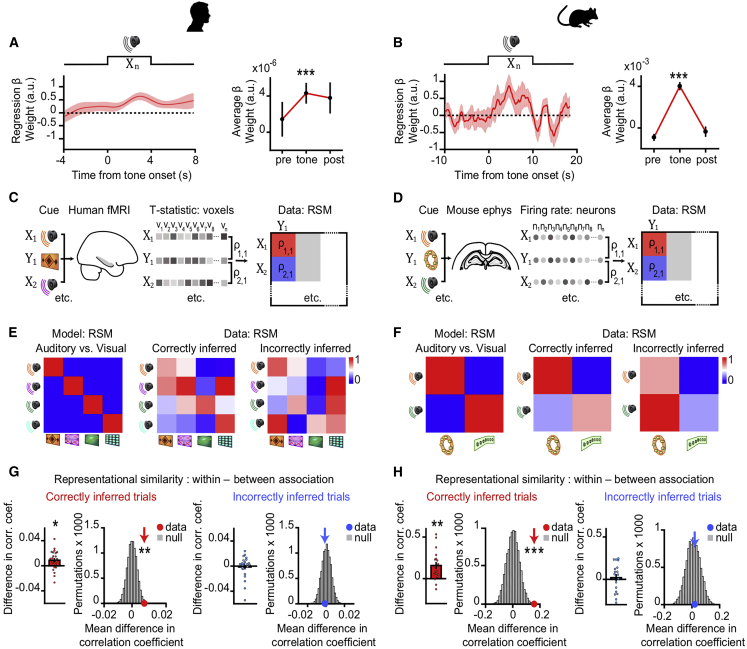
Hippocampal Prospective Memory Code during Correct Inference in Humans and Mice(A and B) During auditory cues Xn in the inference test, the BOLD signal (humans; A) and the Z scored firing rate of each dCA1 neuron (mice; B) were regressed onto the behavioral performance (correct versus incorrect inference) using a GLM. During Xn, the extracted regression weights (mean ± SEM) were significantly positive for correct versus incorrect inference (humans: t21 = 4.04, p < 0.001; mice: t99 = 10.24, p < 0.001).(C and D) In humans (C) and mice (D) hippocampal activity patterns during auditory cues in the inference test and during visual cues in conditioning were compared using RSA to establish a cross-stimulus representational similarity matrix (RSM). In mice, data were filtered by the “decision point” on each trial.(E and F) Average RSMs in humans (E) and mice (F), for the model (predicted results) and the data (observed results), split by behavioral performance in the inference test. Rank-transformed and scaled between (0 to 1) for visualization.(G and H) In both humans (G) and mice (H), hippocampal activity during correctly inferred auditory cues Xn in the inference test significantly predicted the associated visual cue Yn, ([average within association XnYn correlations, RSM main diagonal] – [average between association XnYm correlations, RSM off-diagonals]; correct and incorrect inference; humans: Z21 = 2.24, p = 0.013 and Z21 = 0.71, p = 0.238; mice: Z17 = 3.00, p = 0.001 and Z17 = 0.39, p = 0.348; mean ± SEM). In both species, the group mean was compared against a null distribution generated by permuting the identity labels of cues Xn (correct and incorrect inference; humans: p = 0.005 and p = 0.620; mice: p < 0.001 and p = 0.417; alpha set to 0.05). All statistical tests for correctly inferred trials remained significant with Bonferroni correction to account for two comparisons (correctly and incorrectly inferred), alpha set to 0.025.See also Figures S3 and S4 and Table S4.